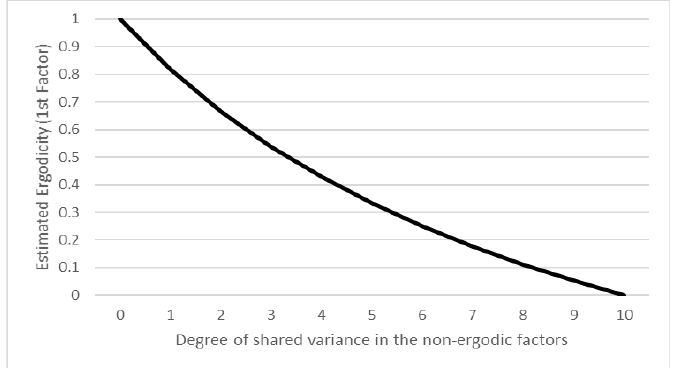
Figure 1. Expectation of the first estimated ergodicity value for different x values in the simulation. The ergodicity values follow ( 1 − x ) 2